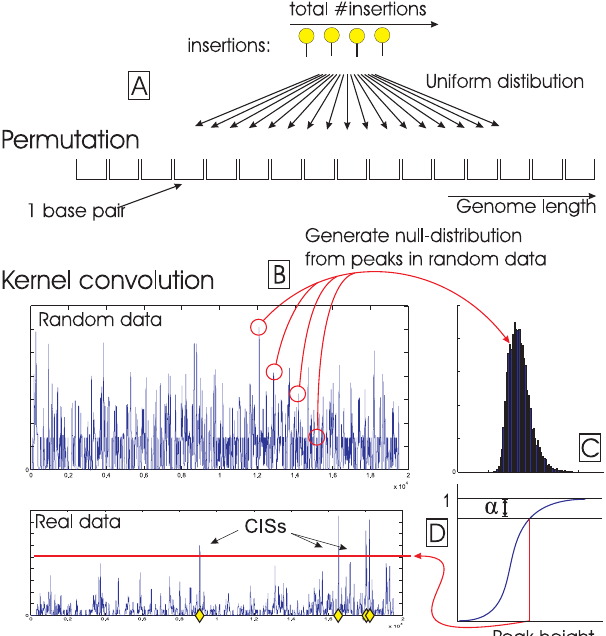
Figure 9. Schematic Depiction of the Significance Analysis of the Density Estimate of the Insertion Data (A) The position of the N insertions is permuted. (B) The convolution method is applied to the resulting permuted insertion profile. The heights of all peaks are recorded. (C) Step A and B are repeated. A distribution of the peaks in random data results. (D) The threshold is computed by determining the a -level in the empirical CDF of the null-distribution. This threshold is applied to the insertion estimate of the real insertion data, resulting in a series of significant